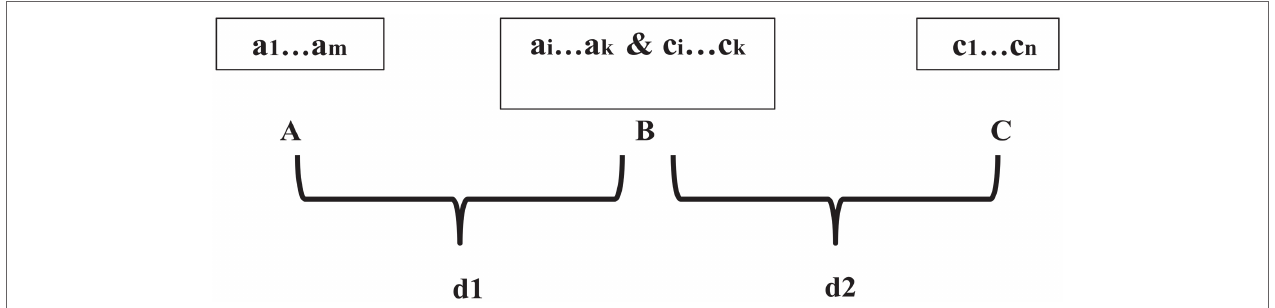
FIGURE 1 | Transitivity in emotive contents in cases of